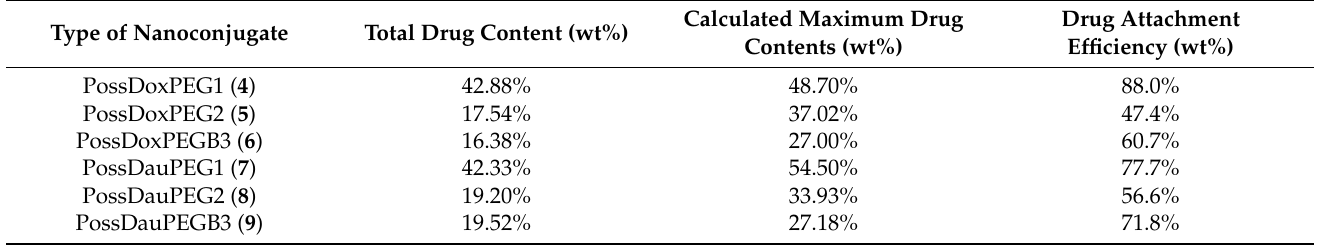
Table 1. Characteristics of conjugates 4 – 9 . Total drug content refers to the weight percentage of the drug in the conjugate. The calculated maximum drug content (wt%) relates to the theoretical maximum drug content—calculated from the weight of drug taken for the reaction. The drug attachment efficiency was calculated on the basis of total drug content and calculated maximum drug content.